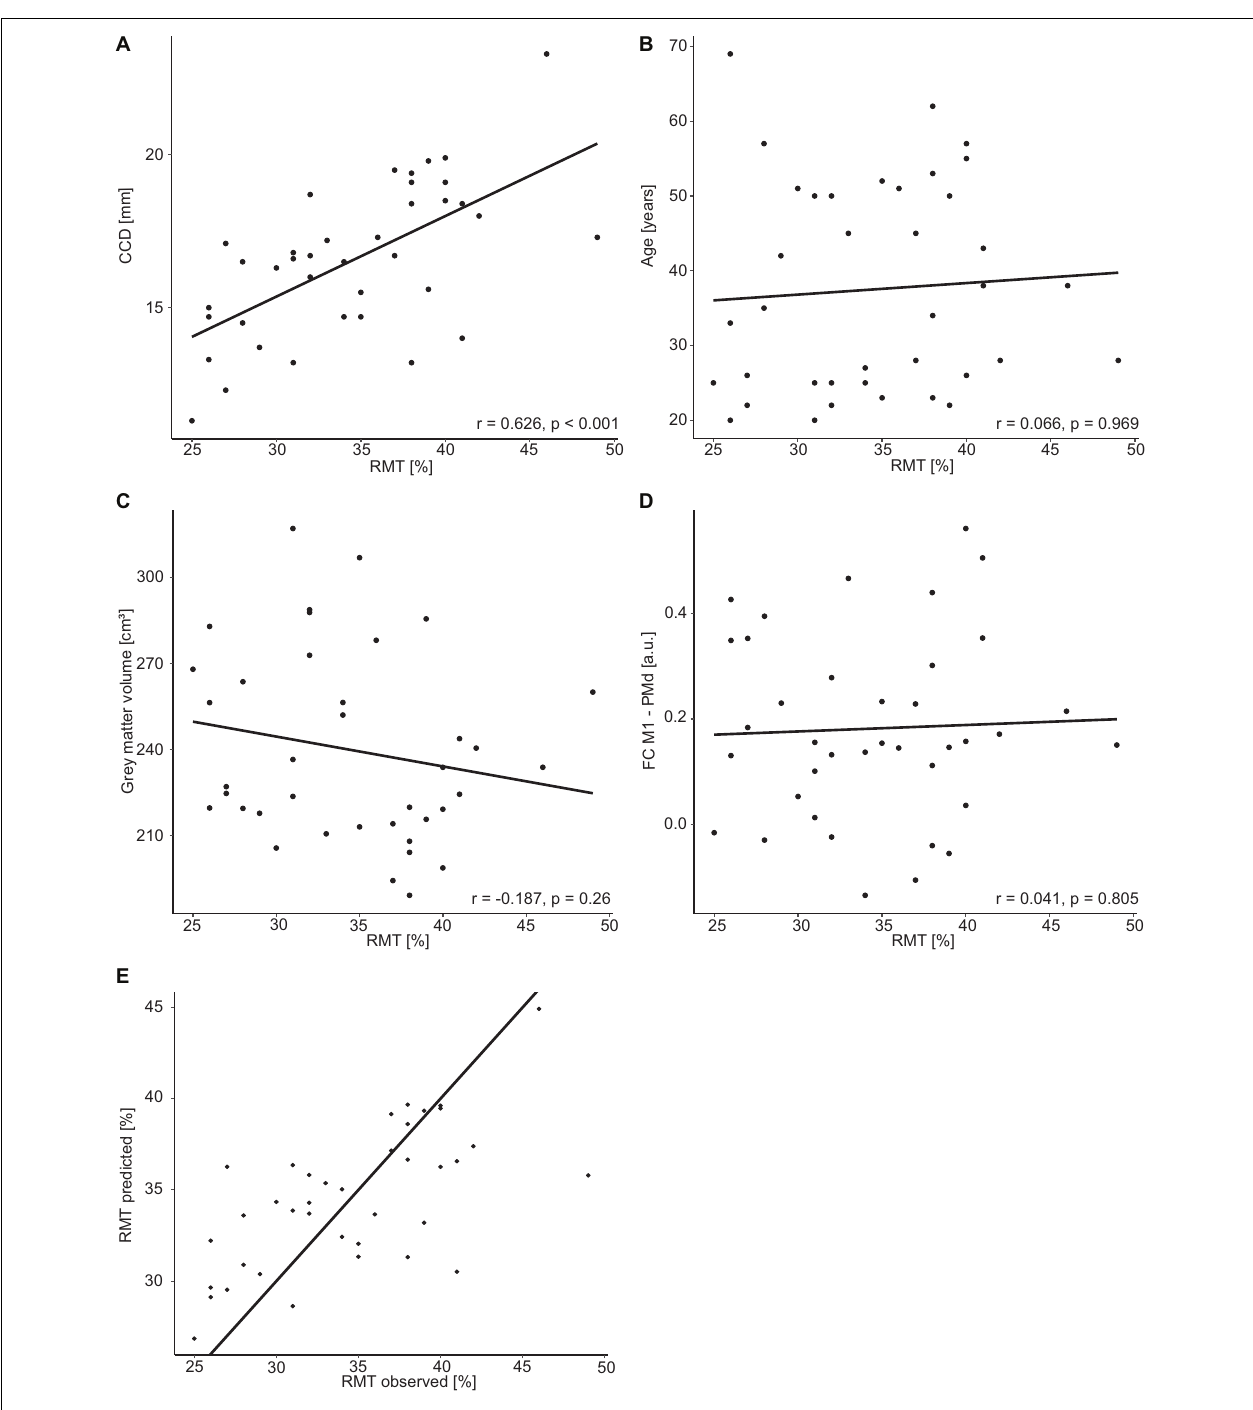
FIGURE 1 | Regression analysis for the dominant hemisphere. Correlation between RMT (%) and CCD (A) , age (B) , gray matter volume (C) , and FC M1–PMd (D) . (E) Observed RMT versus RMT predicted by the model. The diagonal line corresponds to perfect prediction.